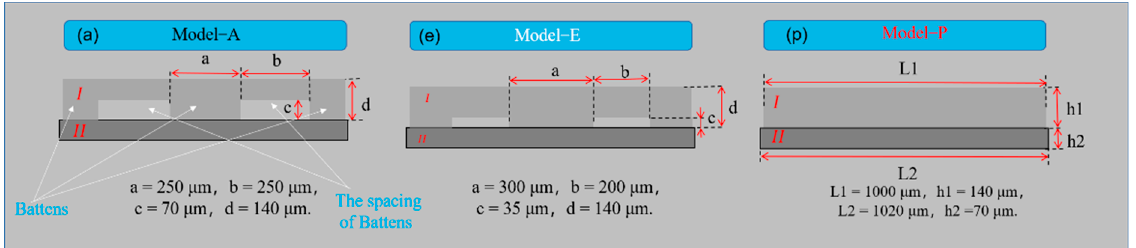
Figure 1. Schematic diagrams of the MCNFs contacting with the electrode (Model − A, Model − E, and Model − P).